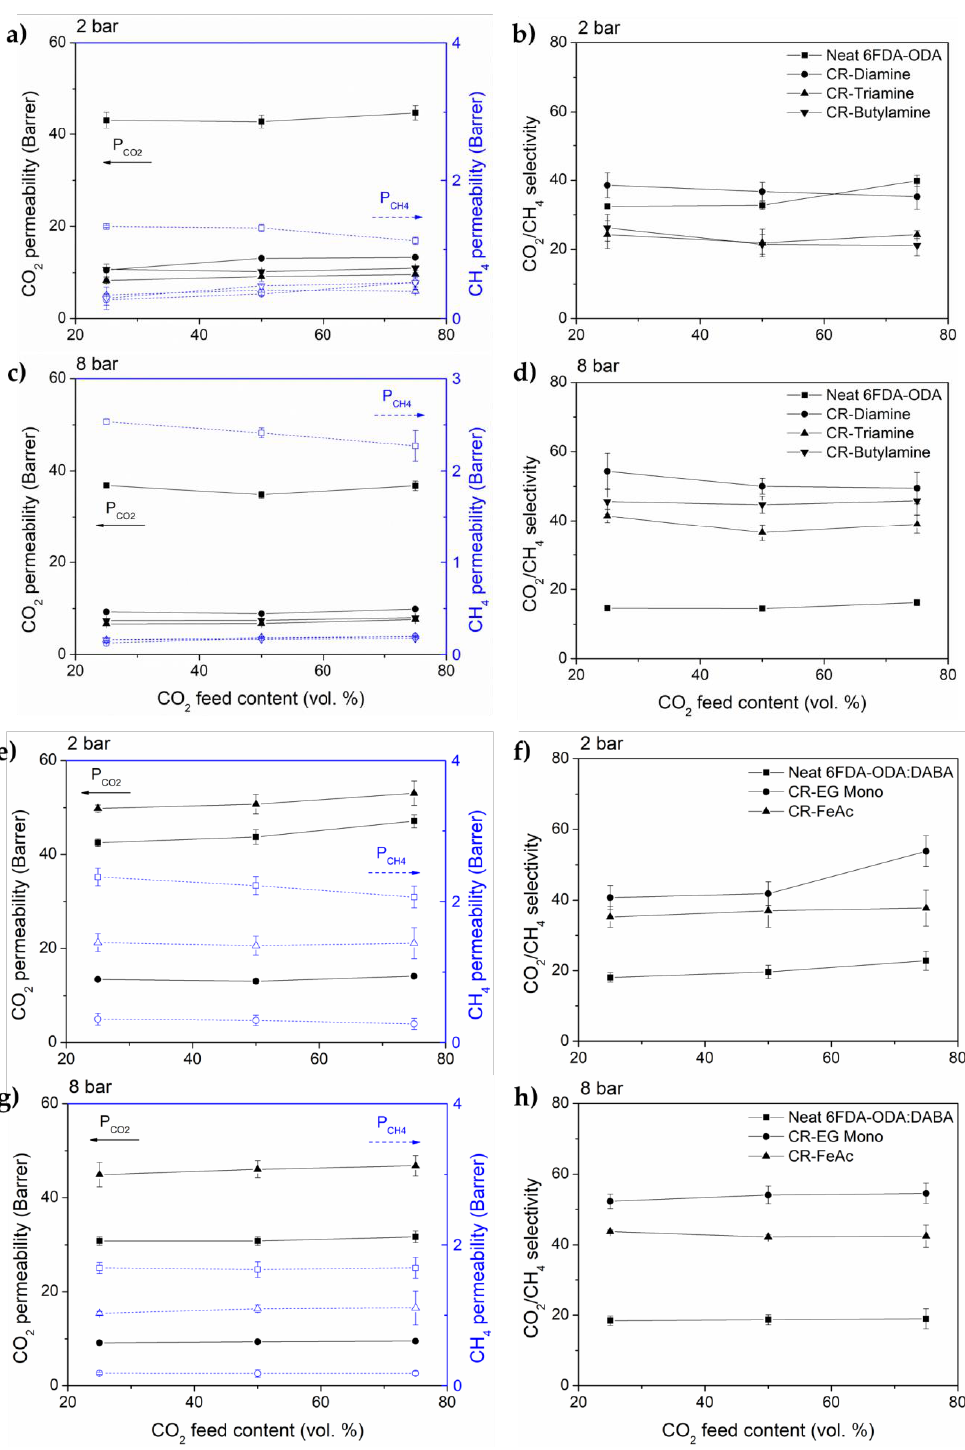
Figure 8. CO 2 and CH 4 permeability and CO 2 /CH 4 selectivity of 6FDA-ODA and its crosslinked membranes at ( a , b ) 2 bar, ( c , d ) 8 bar; 6FDA-ODA:DABA and its crosslinked membranes at ( e , f ) 2 bar and ( g , h ) 8 bar, with 25–75 vol.% CO 2 in the binary feed mixture with CH 4 . All measurement was conducted at 25 °C.